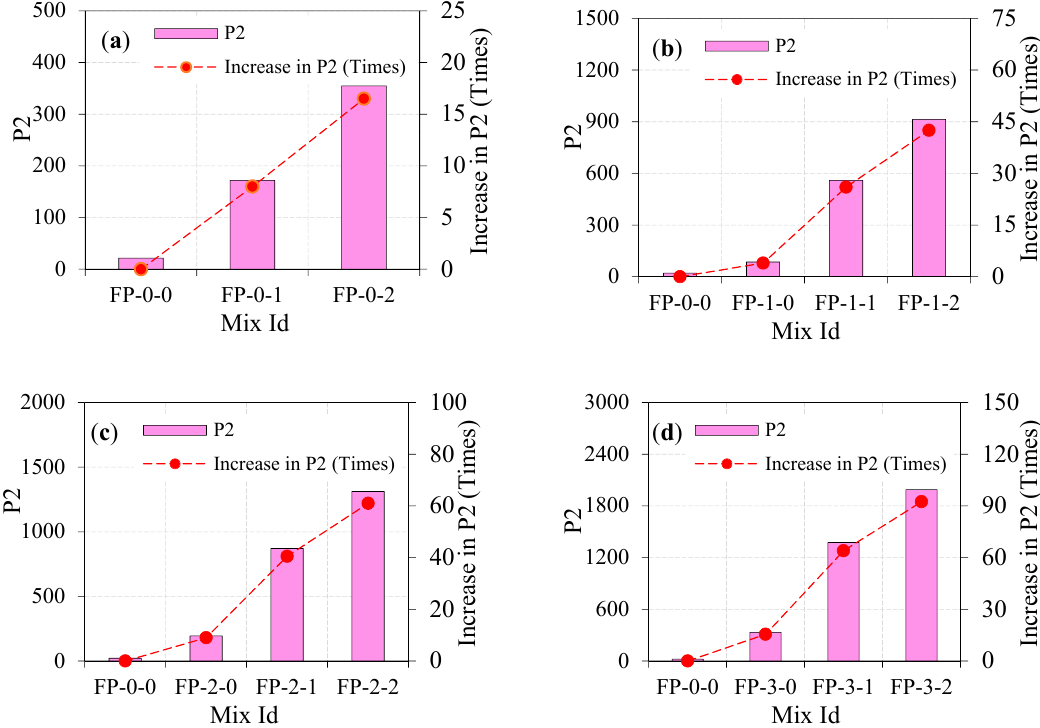
Figure 10. Number of impacts needed to induce failure. ( a ) zero layer mesh; ( b ) one layer mesh; ( c ) two layer mesh and ( d ) three layer mesh